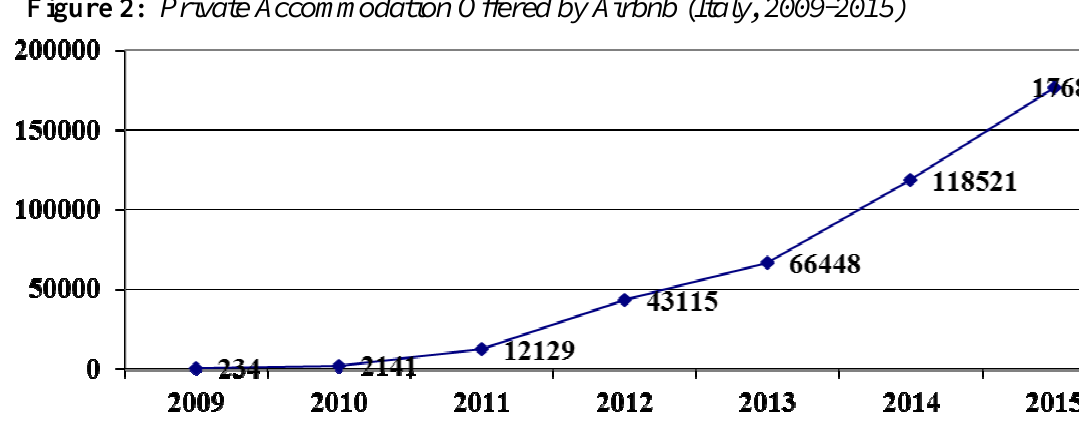
Differentiation